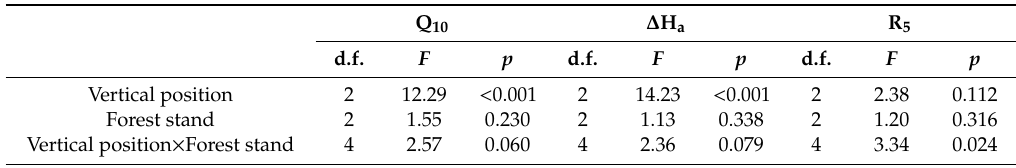
Table 3. Effects of the vertical position, forest stand and their interactions on temperature sensitivity (Q 10 ), activation energy ( Δ H a ), and base respiration (R 5 ) in individual components of ecosystem respiration (ER) by two-way ANOVA analysis.